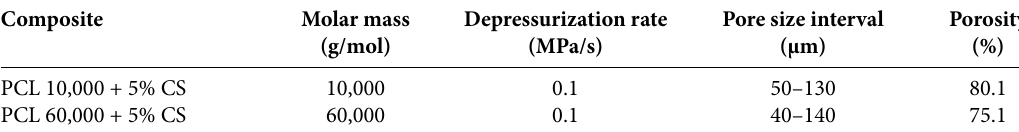
Table 2. Preparation of biodegradable composite material at an applied pressure of 15 MPa and a temperature of 37 °C. Composite Molar mass Depressurization rate Pore size interval Porosity (g/mol)